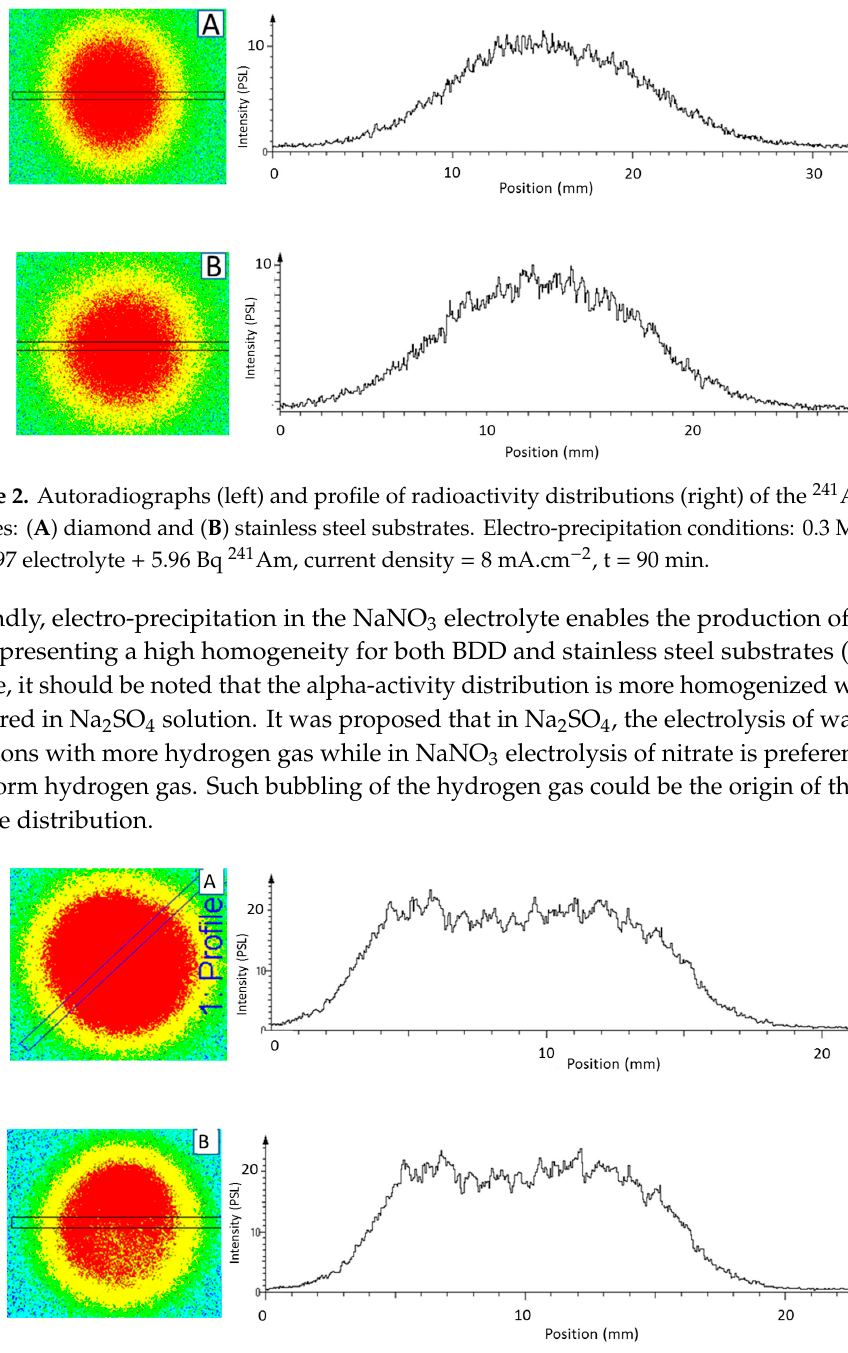
Figure 3. Autoradiographs (left) and profile of radioactivity distributions (right) of the 241 Am alpha sources: ( A ) diamond and ( B ) stainless steel substrates. Electro-precipitation conditions: 0.3 M Na 2 SO 4 pH 3.0 electrolyte + 5.96 Bq 241 Am, current density = 3.3 mA.cm − 2 , t = 90 min.